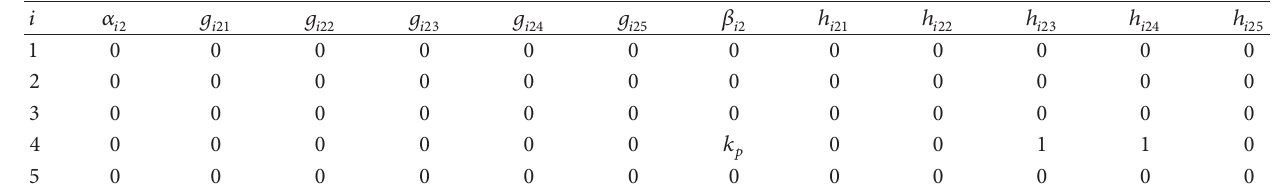
Table 2: Parameters of the interdiffusion model ( 𝑗 = 2).